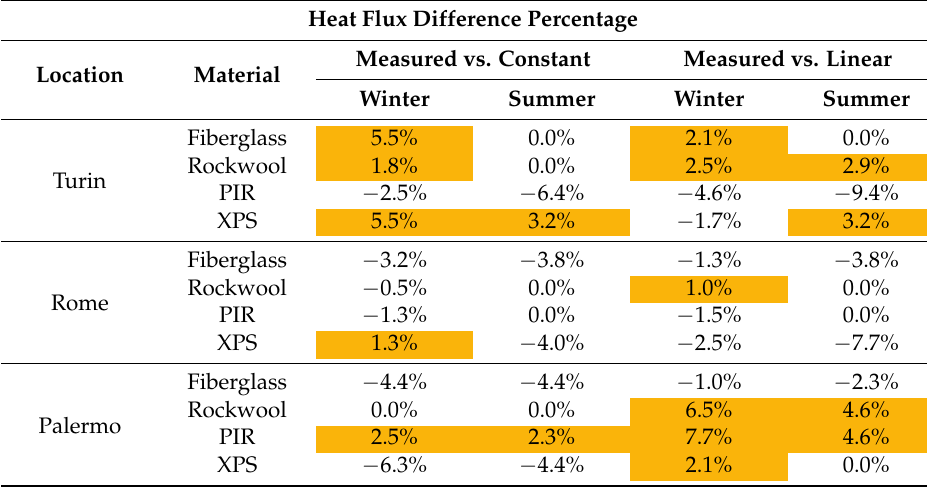
Table 3. Percentage difference of heat flux for exterior